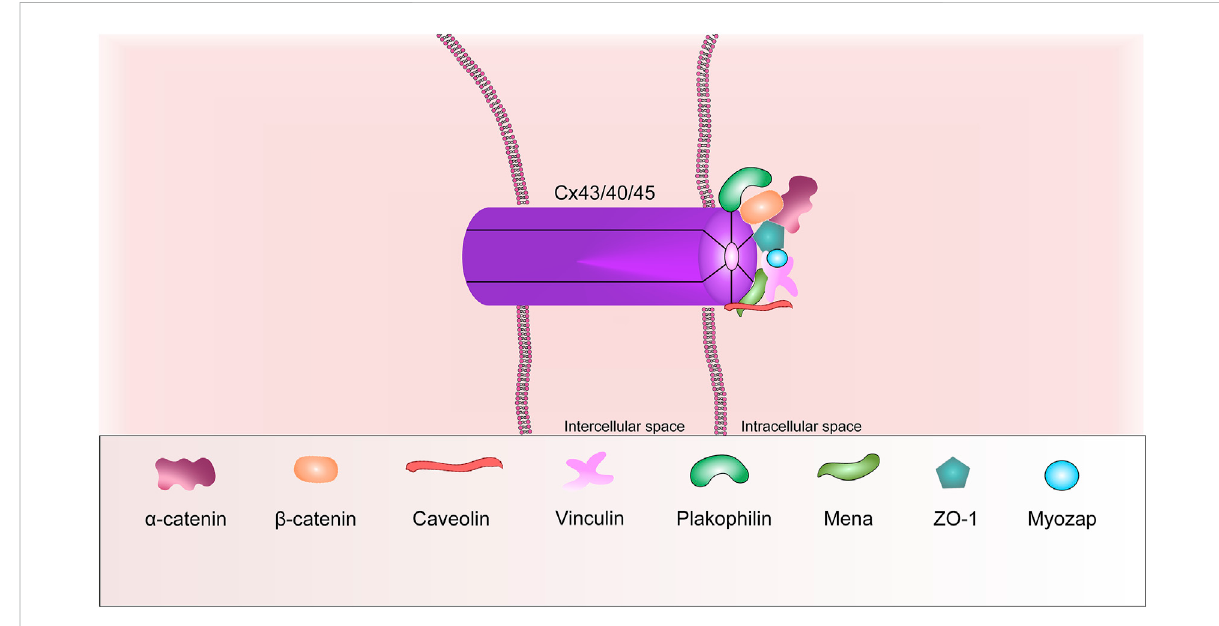
FIGURE 4 Schematic representation of the basic structural components of the gap